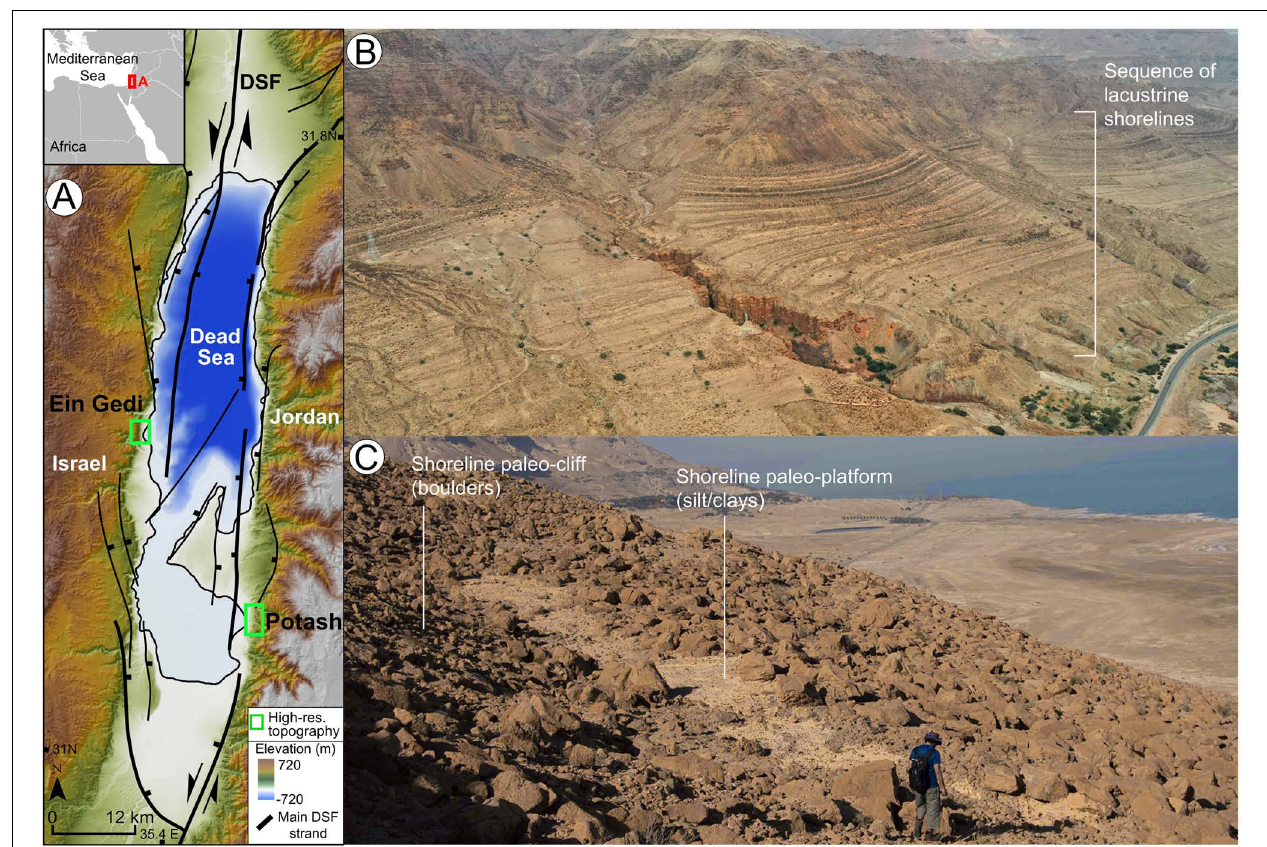
FIGURE 8 | Fossil lacustrine shorelines of the Dead Sea. (A) Tectonic setting of the Dead Sea showing main strands of the Dead Sea Fault (DSF). Green rectangles show location of analyzed sites. (B) Aerial view of lacustrine shorelines in Jordan, dark and light fringes are shoreline cliffs and treads, respectively. (C) Detailed view of a shoreline in Israel, note cliff formed by boulders and the paleo-platform by accumulations of fine sediments.